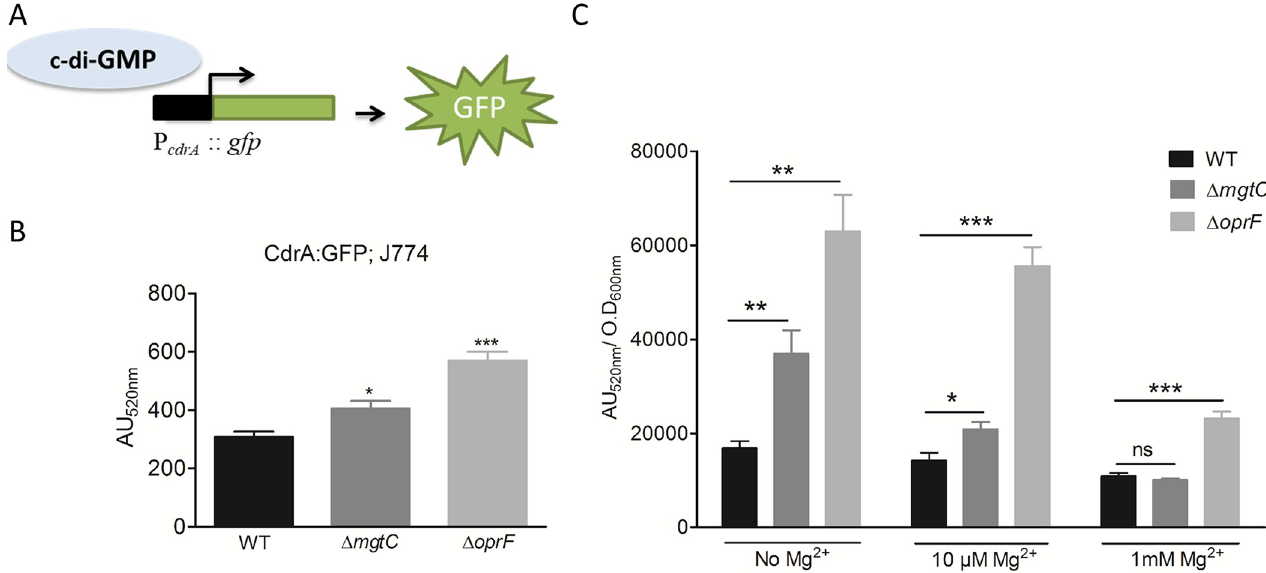
Fig 5. Measurement of c-di-GMP level in Δ mgtC and Δ oprF mutants. PAO1 WT, Δ mgtC and Δ oprF harboring reporter plasmid pCdrA:: gfp , which expresses GFP under the control of the promoter of c-di-GMP responsive gene cdrA (A), were used to infect J774 cells and fluorescence was measured (B). After phagocytosis, DMEM containing 300 μ g/ml of amikacin was added to eliminate extracellular bacteria. Fluorescence (excitation, 485 nm and emission, 520 nm) was measured 1 hour after phagocytosis and plotted as arbitrary units (AU). Error bars correspond to standard errors from four independent experiments. The asterisks indicate P values (One way ANOVA, where all strains were compared to WT using Dunnett’s multiple comparison post-test, � P < 0.05 and ��� P < 0.001), showing statistical significance with respect to WT. (C) PAO1 WT, Δ mgtC and Δ oprF harboring reporter plasmid pCdrA:: gfp , were grown in NCE medium with varying concentration of Mg 2+ . After 1 hour of growth, fluorescence (excitation, 485 nm and emission, 520 nm) of the culture was measured along with its OD 600nm . The fluorescence was plotted as arbitrary units (AU 520nm ) after normalizing with OD 600nm . Error bars correspond to standard errors from three independent experiments. The asterisks indicate P values showing statistical significance with respect to WT in the respective condition, using Student’s t test (ns = P > 0.05, � P < 0.05, �� P < 0.01 and ��� P < 0.001).